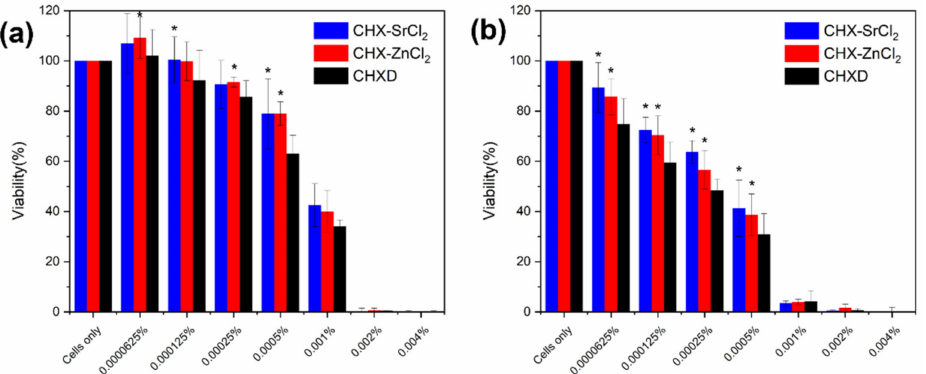
Figure 6. Effects of CHXD, CHX-SrCl 2 , and CHX-ZnCl 2 on the relative viability of fibroblast (L929) cells at ( a ) 24 h and ( b ) 48 h. Values shown are mean (SD) for triplicate cultures. * p < 0.05 = significant difference within groups vs.